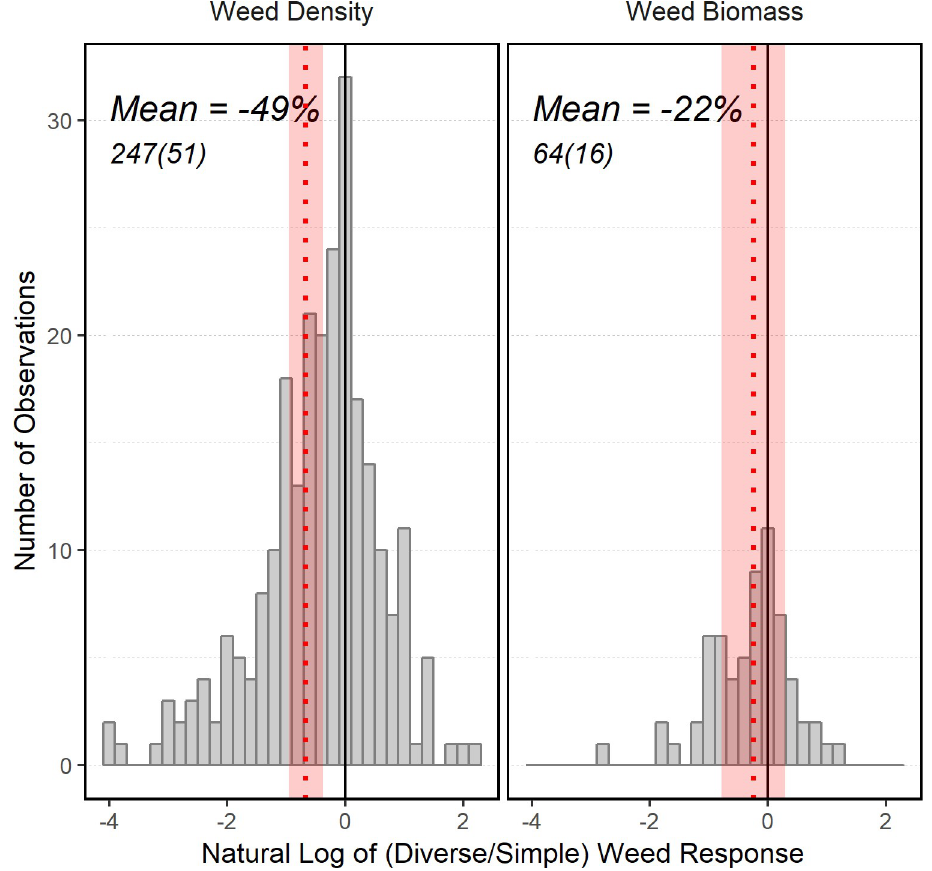
Fig 2. Histogram of weed response (weed density and biomass) to diversifying from a simple rotation. Means (dotted lines) and standard errors of the means (shaded areas) on a natural log scale, mean value on a percent change scale, total number of observations, and number of studies